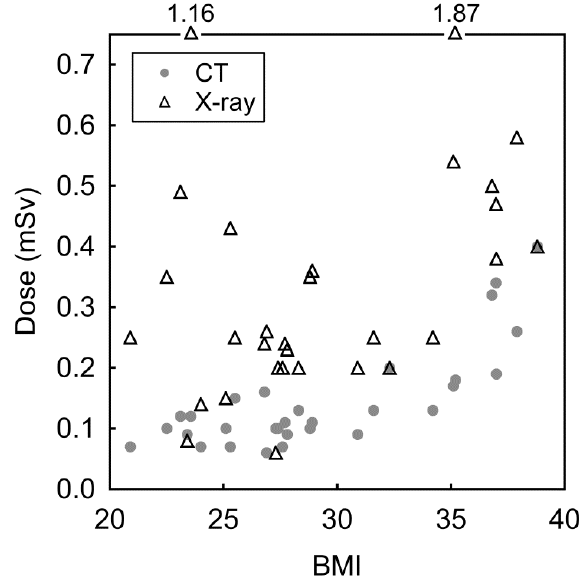
Fig. 2. The dependence radiation dose on BMI. Both TFULDCT- and radiograph-associated doses were significantly positively correlated to patients’ BMI.